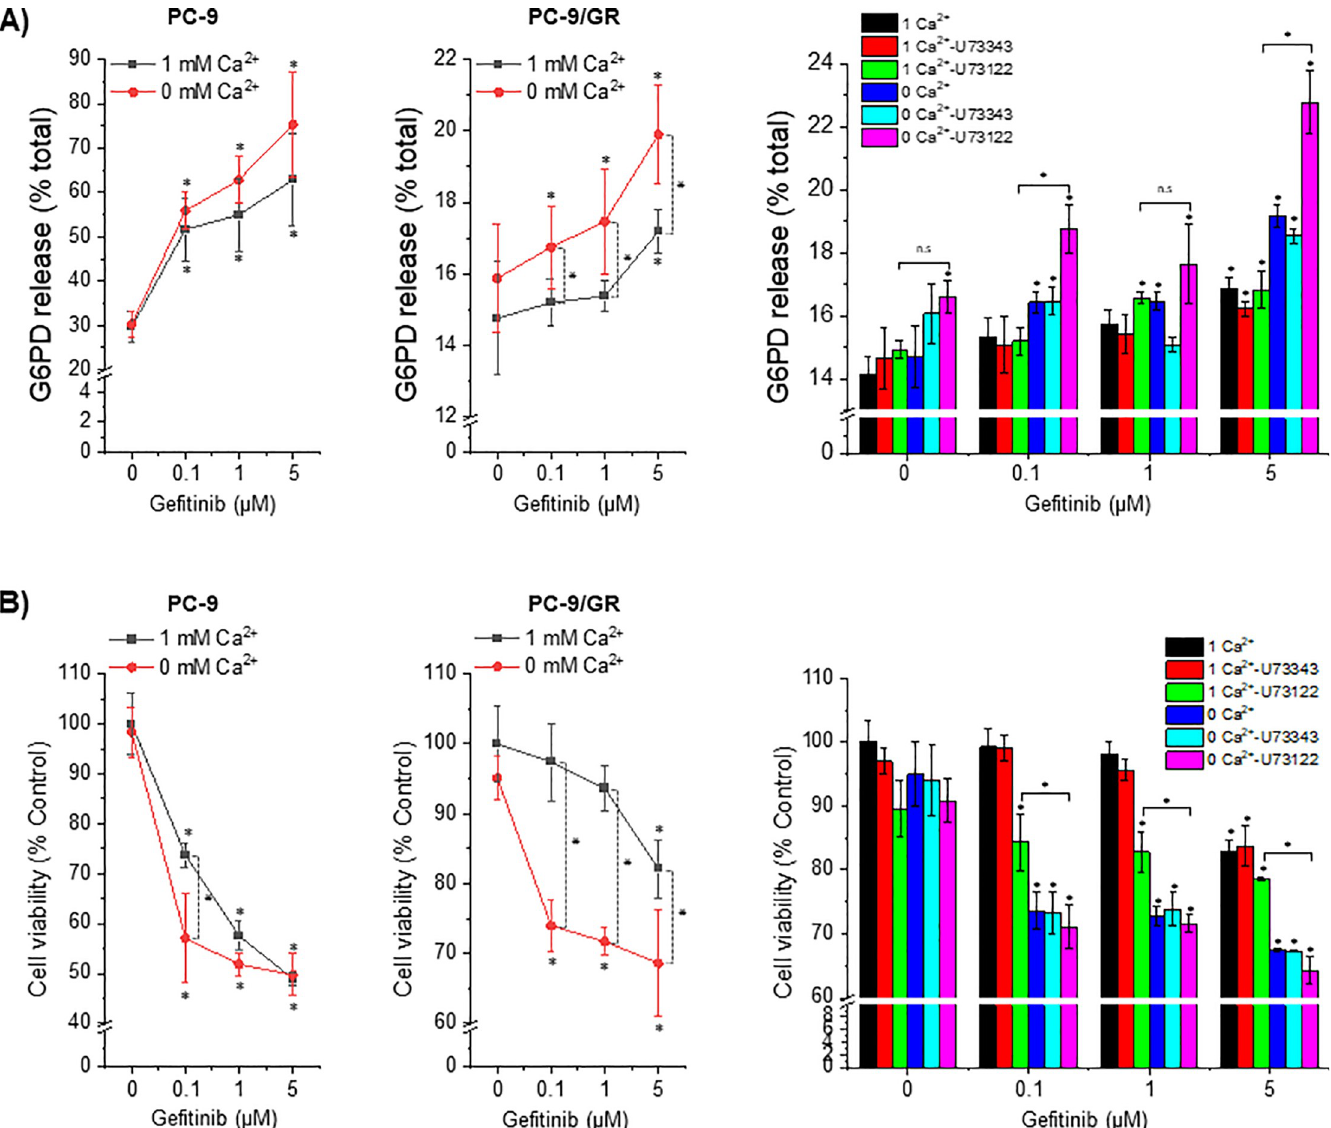
Fig 3. Synergistic effects of low [Ca 2+ ]e and U73122 on gefitinib-mediated cytotoxicity. Gefitinib-treated cells with or without [Ca 2+ ]e and U73122 were incubated for 24 h and 48 h to evaluate cytotoxicity and cell viability, respectively. (A) Gefitinib-induced cytotoxicity in PC-9 and PC-9/GR cells was evaluated by measuring G6PD activity. Data are presented as proportion of released G6PD (% total; n = 4), and are given as the mean ± S.D. � P < 0.05 compared with control (only vehicle-treated in 1 mM Ca 2+ ) group or between indicated groups (B) Cells cultured under indicated conditions were incubated for 48 h and subjected to cell viability assay. Data are presented as relative to control (% control; n = 4) and given as mean ± S.D. � P < 0.05 compared with control (only vehicle-treated in 1 mM Ca 2+ ) group or between indicated